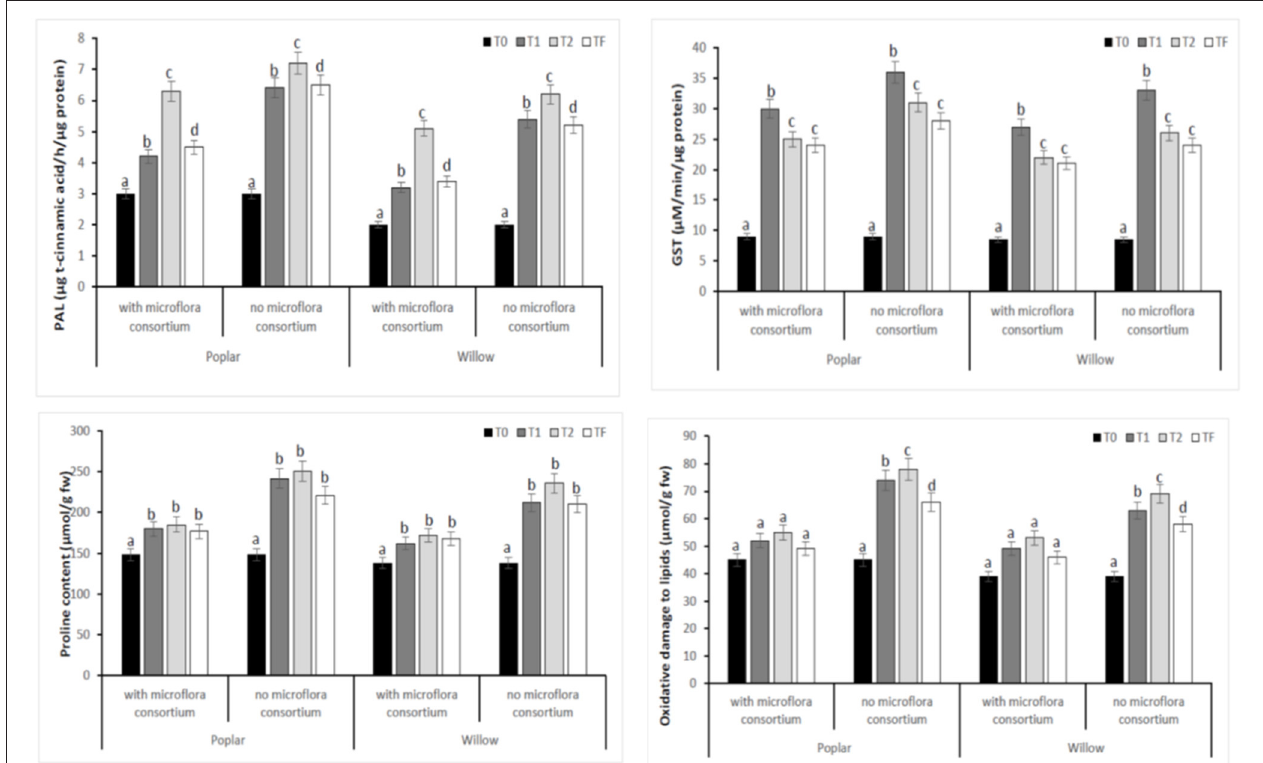
FIGURE 9 | Enzymatic activities of PAL, GST, Proline, and MDA in leaves of hybrid poplar Populous deltoids × Populous nigra and willow Salix purpurea subsp. lambertiana at different monitoring time (T 0 :0, T 1 :12, T 2 :24, and T F : 36 months) with microflora consortium and no microflora consortium. Mean values ±